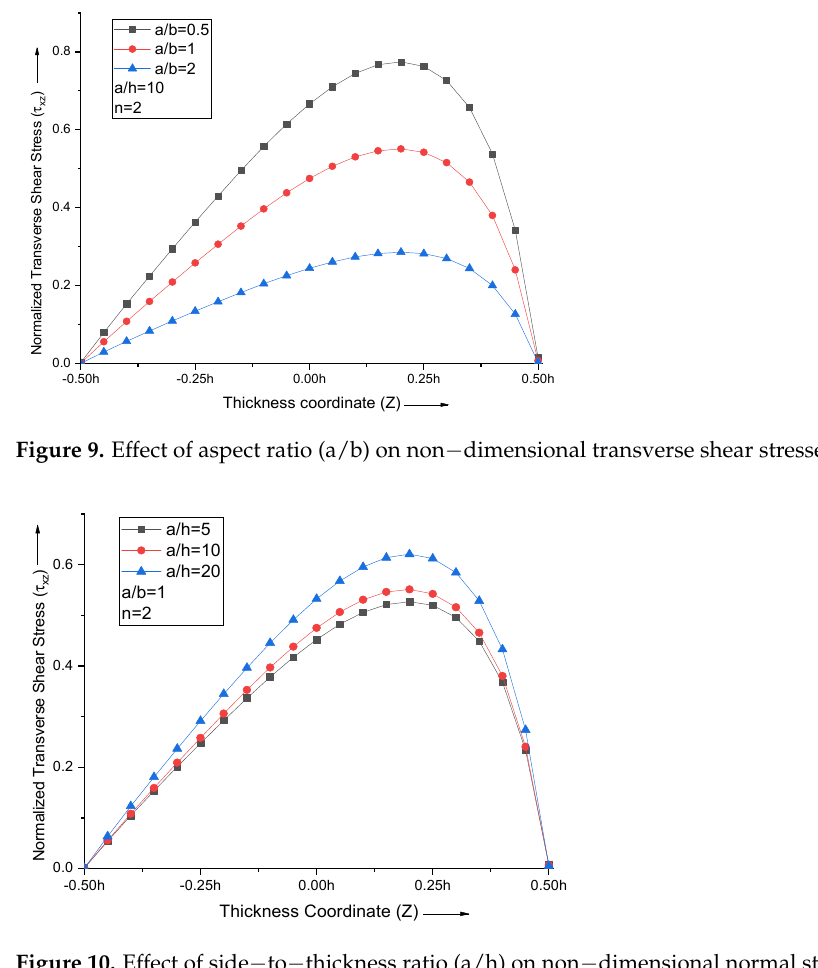
The transverse shear stress appears to give a maximum response at the mid-point of the Figure 10. Effect of side − to − thickness ratio (a/h) on non − dimensional normal stresses of the plate. edge which allows the corresponding shear rotation at the edge.